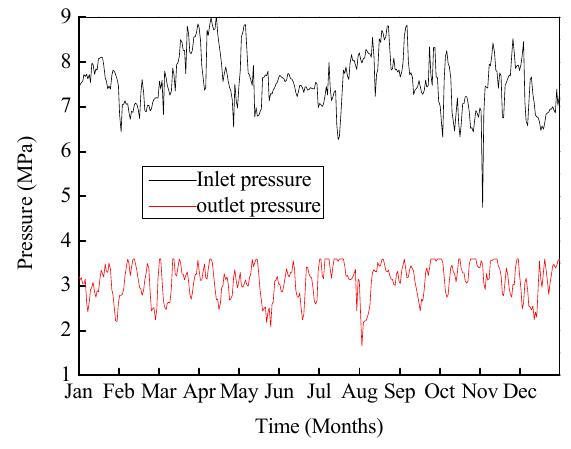
Figure 12. Inlet/outlet pressure of natural gas during 2014.